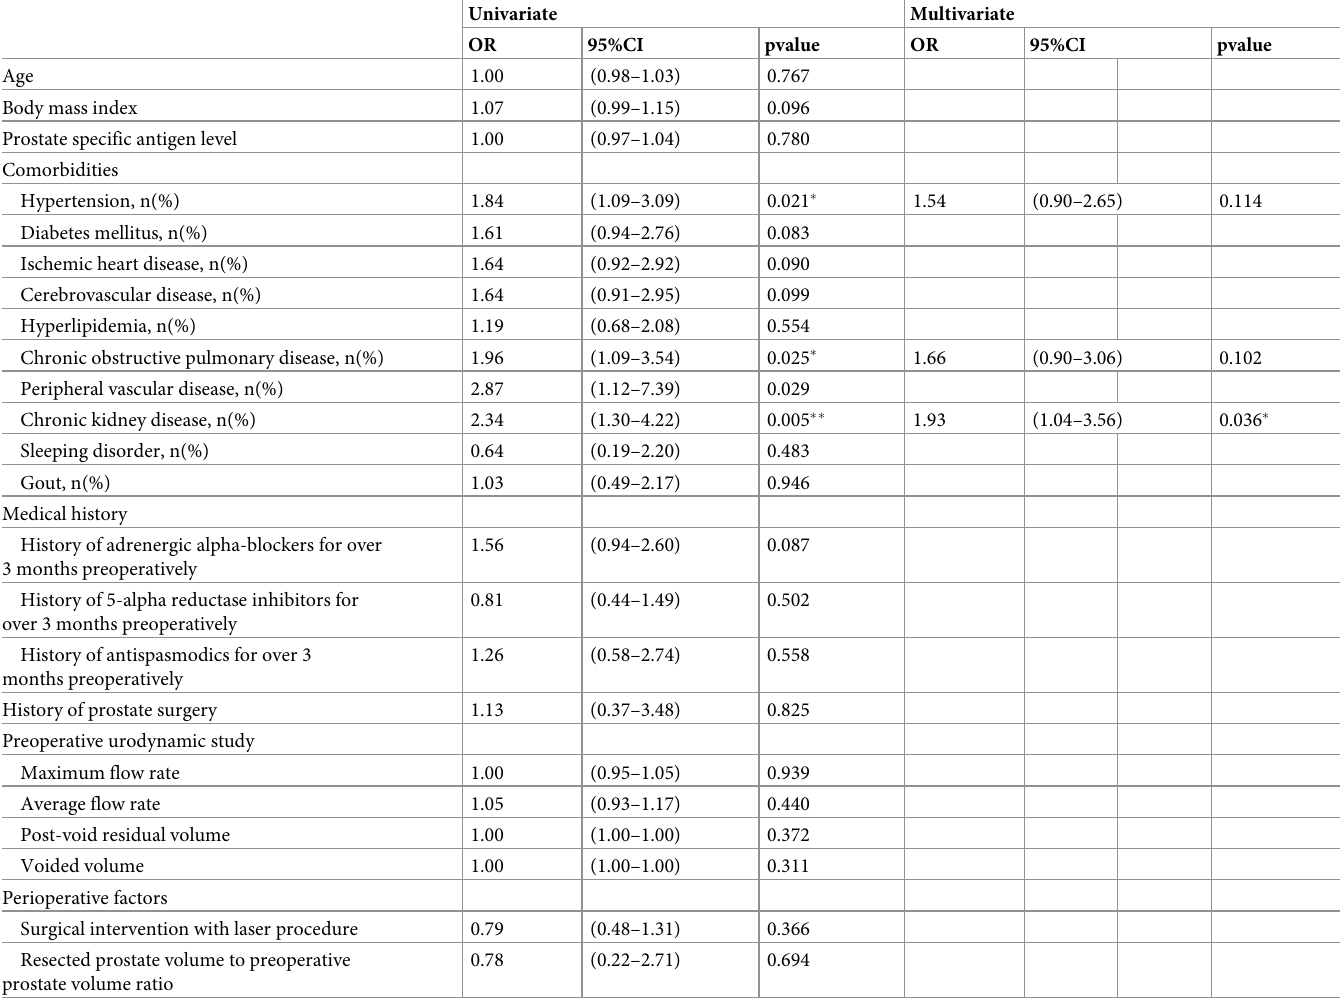
Table 2. Logistic regression analyzing factors that are associated with postoperative adrenergic alpha-blockers